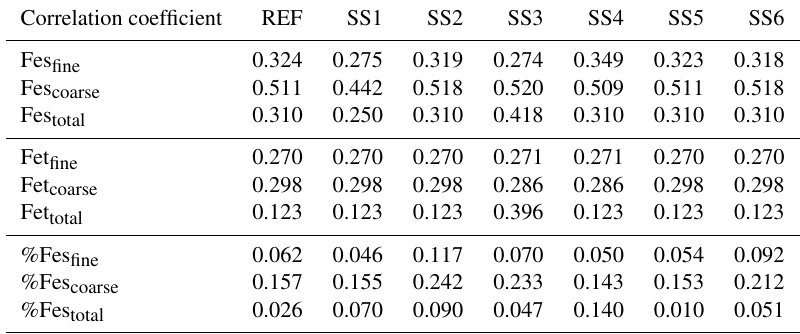
Table 4. Correlation coefficients for the reference case and sensitivity studies 1–6.